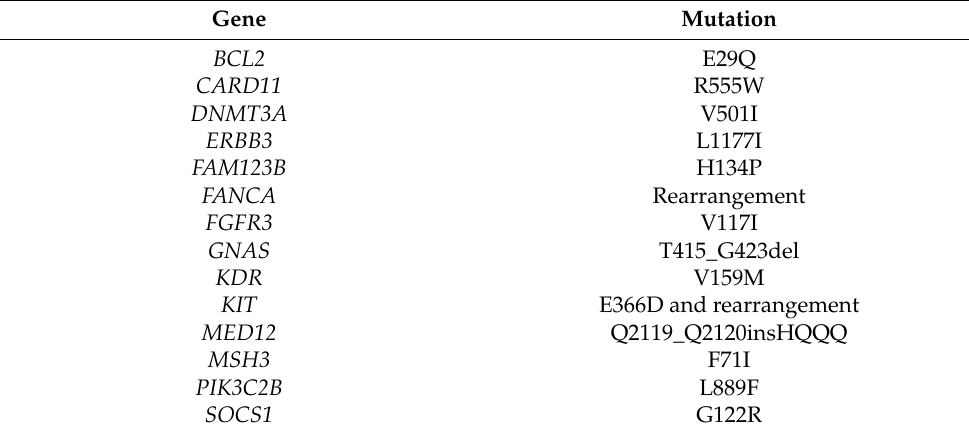
Table 2. Variants of unknown significance (VUS) detected in the patient’s tumor sample.